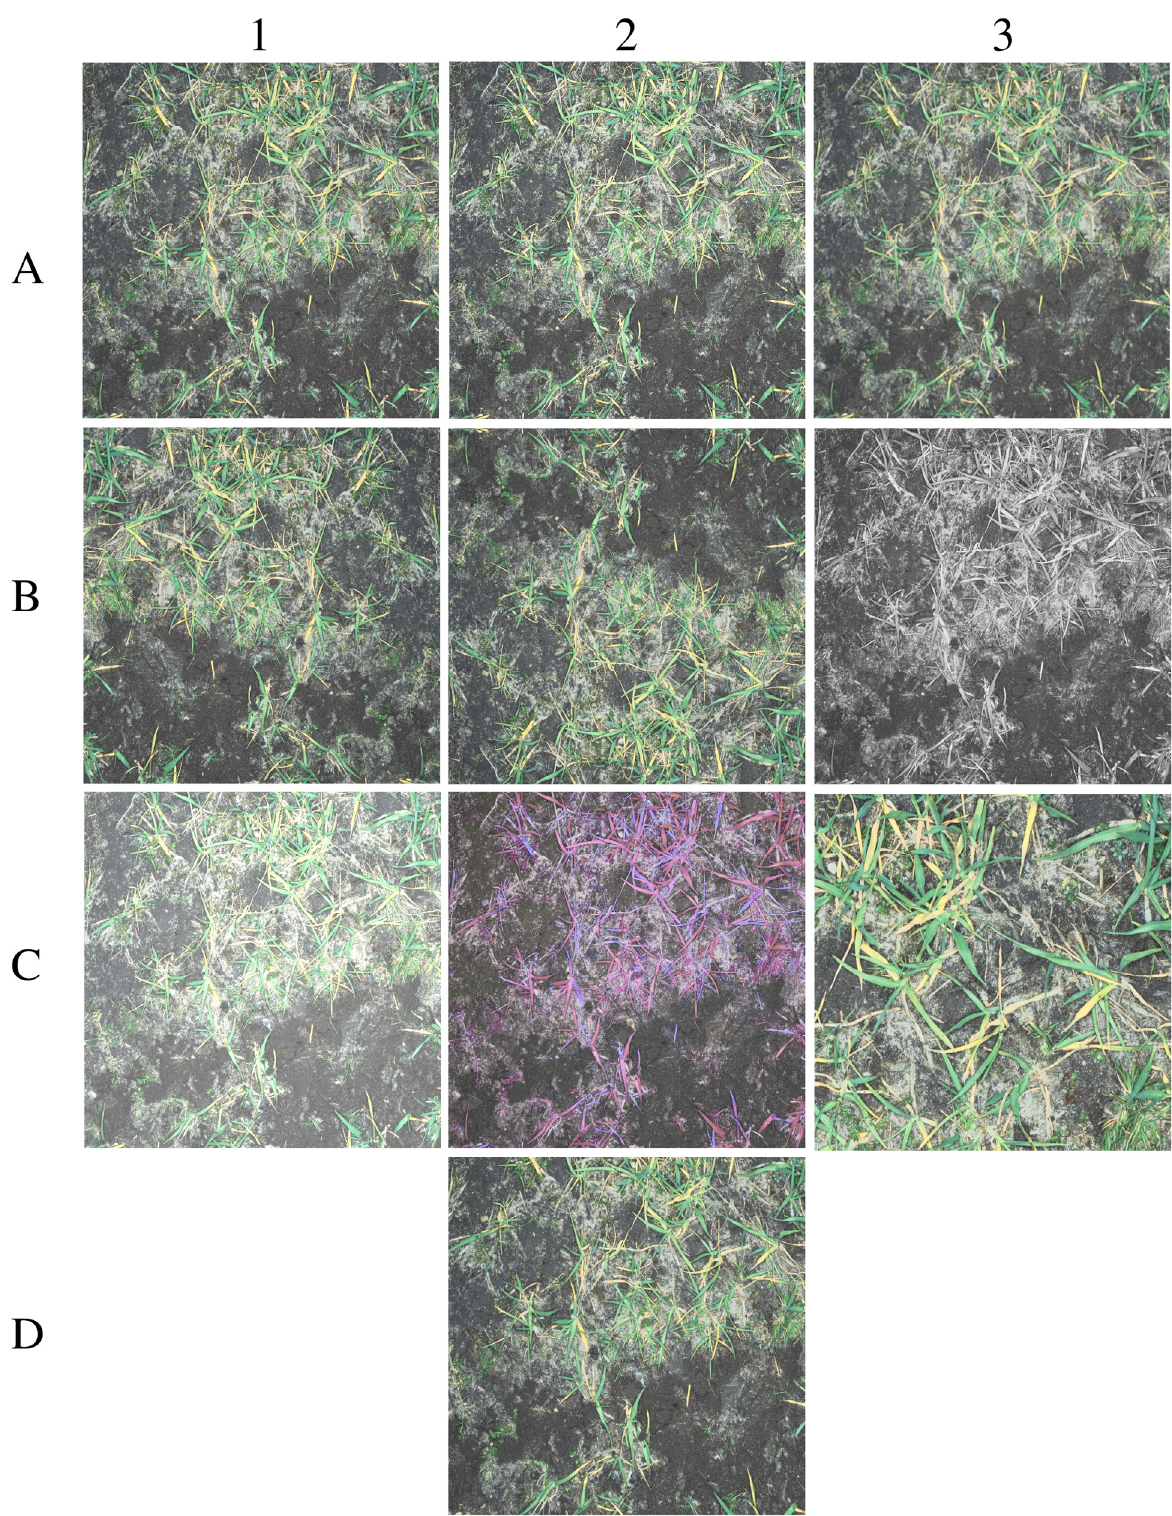
Figure 7. Various image augmentation techniques: ( A1 ) original; ( A2 ) contrast; ( A3 ) blurring; ( B1 ) horizontal flip; ( B2 ) vertical flip; ( B3 ) color to gray; ( C1 ) brightness; ( C2 ) RGB shift; ( C3 ) cropping; and ( D2 ) scaling methods.